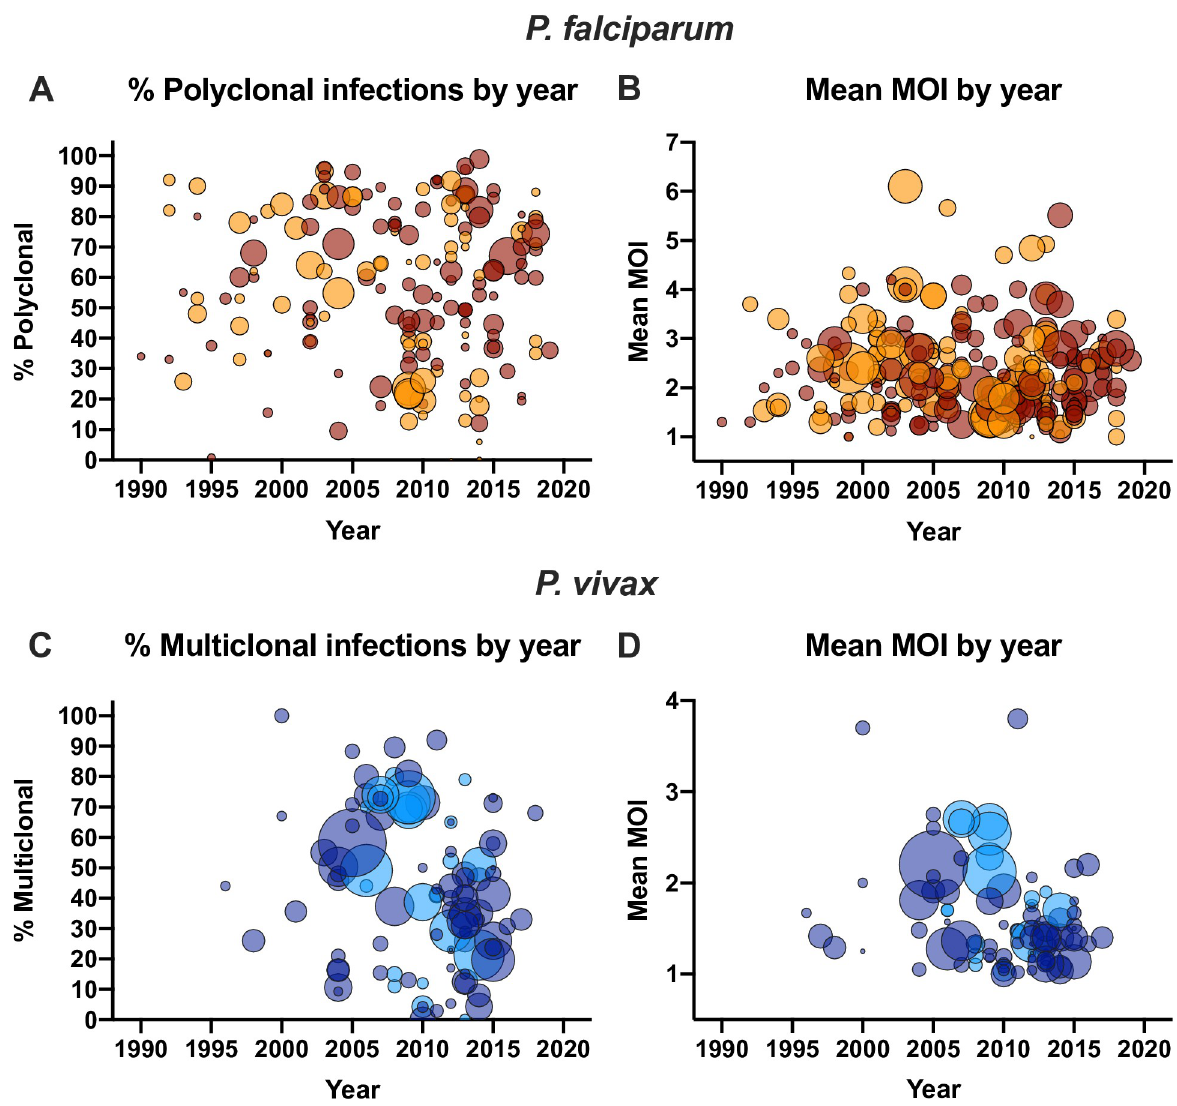
Fig 2. Relationship between year of sample collection and the proportion P . falciparum and P . vivax polyclonal infections (A, C) or mean multiplicity (B, D). Dot sizes represent the number of individuals genotyped. Dark red/dark blue = samples collected form clinical patients. Orange/light blue = samples collected form asymptomatic individuals. Overlapping data points result in darker colors.